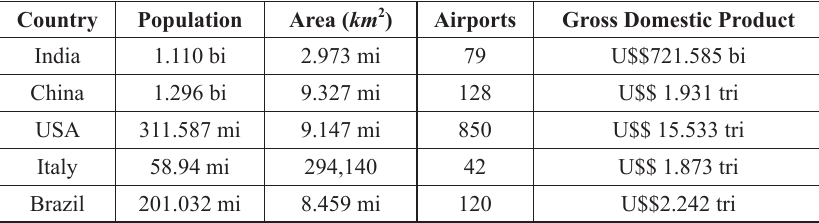
Some important indicators of each